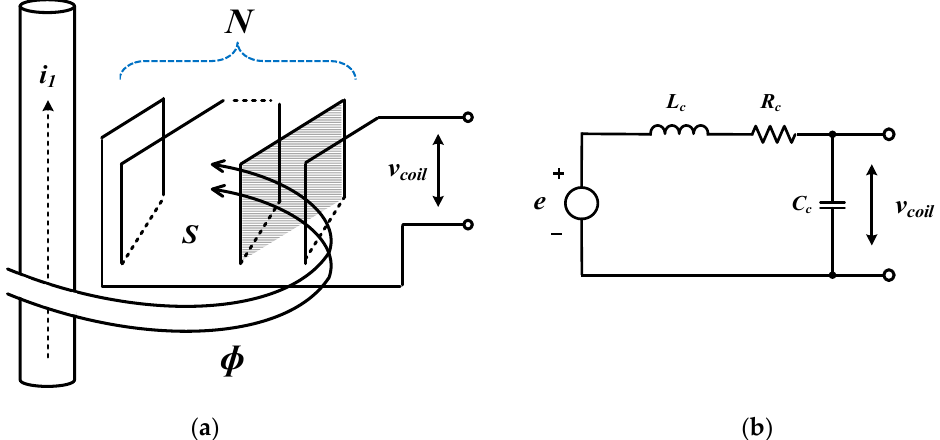
Figure 1. Schematic diagram of a pick-up coil: ( a ) principle of a pick-up coil; ( b ) equivalent lumped circuit.